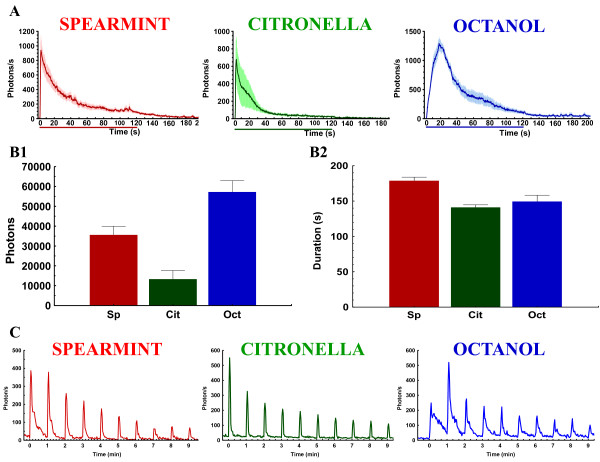
Odor-induced Ca2+-activity is maintained all along the 2-min odor application, and is sensitive to the frequency of the odor-repetition. (A) Mean of the amplitude (+/-SEM) of the response (photons/s) versus time, of the Ca2+-induced response evoked by a long odor application (2 min) (represented by the colored bar below the abscissa) for the three tested odors (n = 6 flies for each odor). Interestingly, we note that the Ca2+-response in the axon terminal is maintained (although it decreases) at least during the 2-min odor application (for each of the three tested odors), but rapidly decreases when the odor application is stopped. (B) Total amount of emitted photons and duration of the response of the 2-min odor application for each odor. The duration of the response is longer than 2 min (Sp = 178 s, Ci = 141 s, Oct = 149 s). C) Amplitude of the response (photons/s) of a representative fly, versus time, of the Ca2+-induced response (within the ROI) evoked by 5 s application of spearmint, citronella, and octanol, repeated 10 times at 1 min-interval. For octanol, we remark that since the duration of the first response is very long (> 60 s), the Ca2+-response of the first odor-application is not yet finished when the second odor application occurs (which likely explains why for the second application, the amplitude is higher than for the first one).